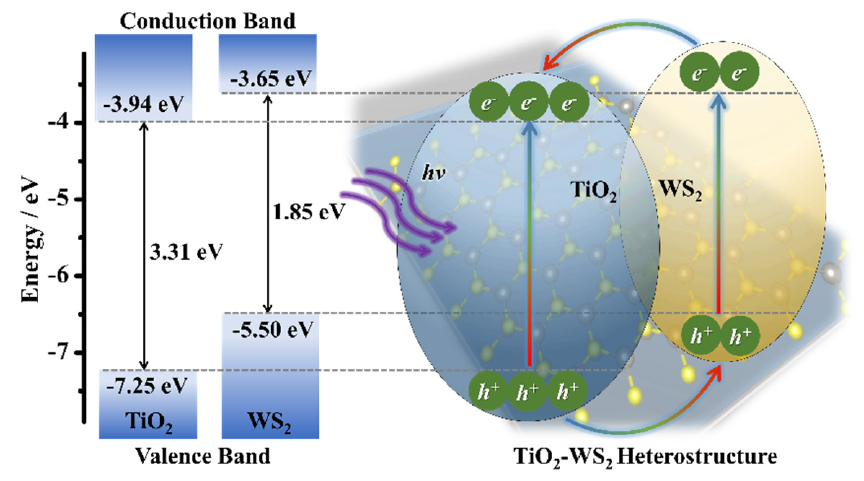
Figure 7. Photoinduced degradation of ( a ) stearic acid and ( c ) RhB on the WS 2 -TiO 2 films, and the pseudo-first-order fit of ( b ) stearic acid and ( d ) RhB decay at increasing times of UV irradiation: undoped TiO 2 (grey line), TiO 2 -WS 2 -U (black line), TiO 2 -WS 2 -L (red line), and TiO 2 -WS 2 -S (blue